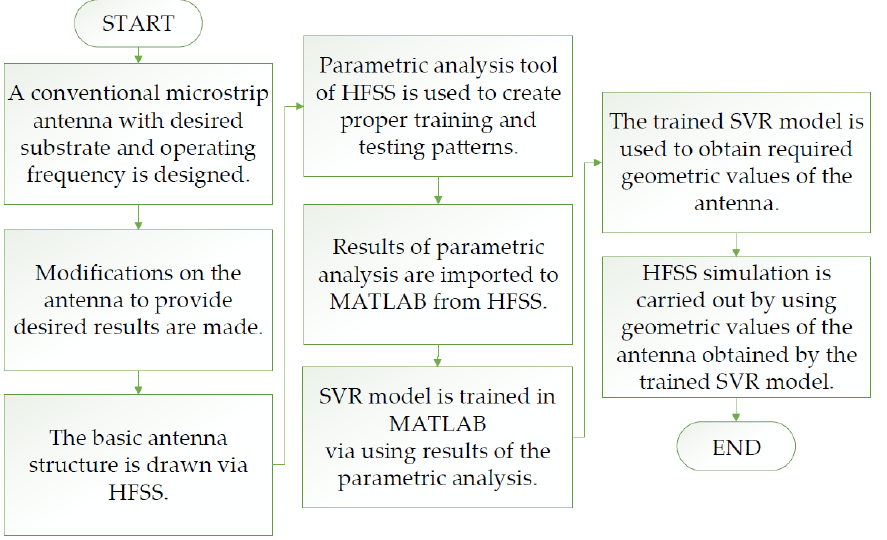
Figure 2. Flow chart of the design procedure.